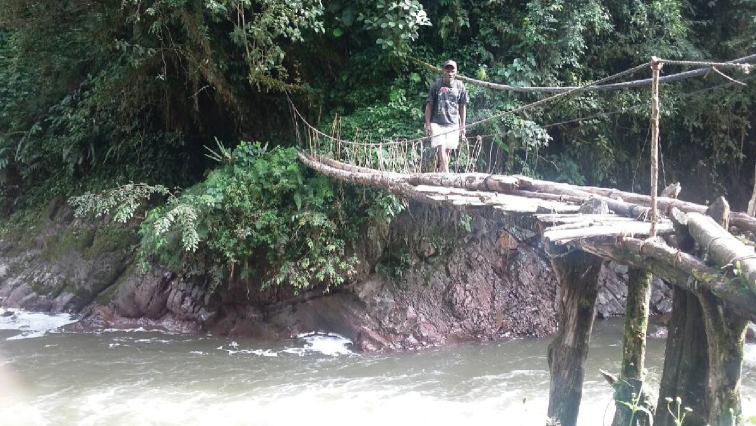
Tsingogong River.